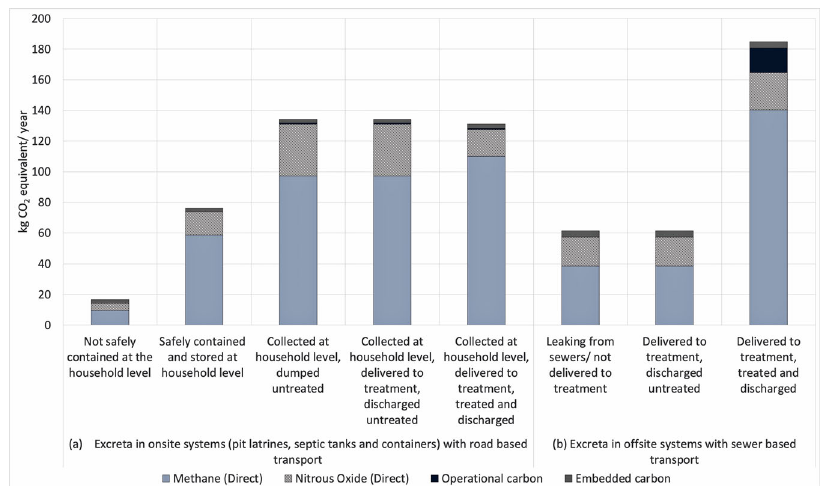
Fig. 3 Aggregate per-capita annual emissions from excreta in Kampala by sanitation pathway and ultimate fate. Vertical bars represent the total annual emissions associated with the excreta of one person travelling along the designated sanitation pathway from collection, through emptying and transport to treatment (where relevant) for on-site systems ( a ) and offsite systems ( b ). The direct emissions of methane (solid pale grey) and nitrous oxide (shaded grey), indirect operational emissions associated with trucking and pumping (black) and embedded carbon (solid dark grey) for each stage of sanitation are summed in each case. The second, fi fth and eighth bars represent emissions from fl ows, which are safely separated from human contact (known as ‘ safely managed ’ sanitation). All other pathways result in risk of human exposure to faecal matter and leakage into the